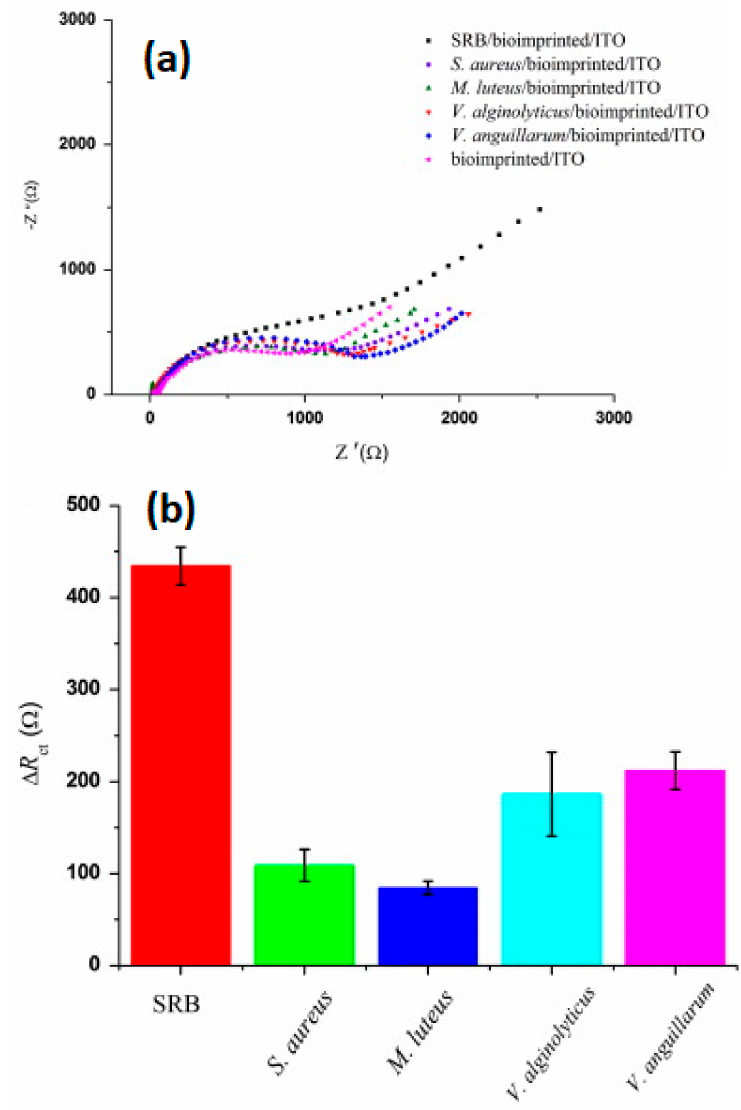
Figure 23. Impedance spectra obtained with bioimprinted sensor and the biosensor after incubation with 1.0 × 10 8 cfu mL − 1 SRB, S. aureus, M. luteus , V. anguillarum , and V. alginolyticus in PBS con- taining 5 mM Fe(CN) 64 − /3 − as the probe ( a ).The comparison of Rct changes of the impedimetric biosensor based on SRB-mediated bioimprinted film to SRB, S. aureus , M. luteus , V. anguillarum , and V. alginolyticus ( b ). DRct is the change of charge transfer resistance of impedimetric sensor before and after incubation with different bacteria. Reproduced with permission of Elsevier from